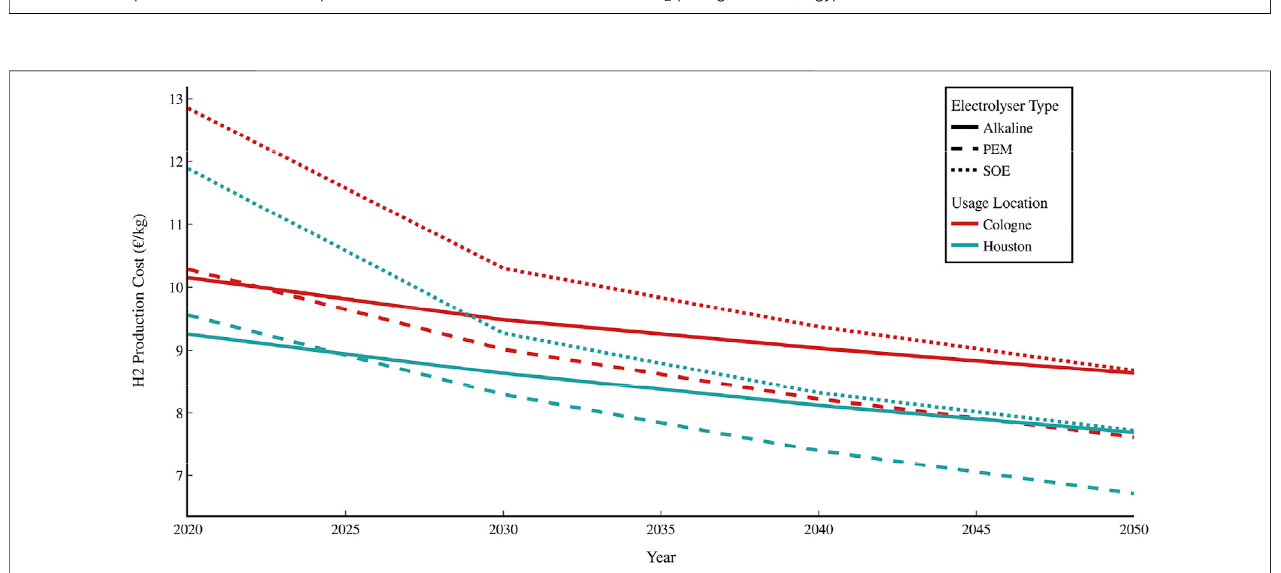
FIGURE 11 | Cost per kg of producing and transporting H 2 to Cologne and Houston for each electrolyser type from 2020 – 2050. The other parameters are the same as for the baseline scenario (100 kt/y capacity, centralised reconversion). Results are the average from a Monte Carlo simulation with 1,000 iterations.